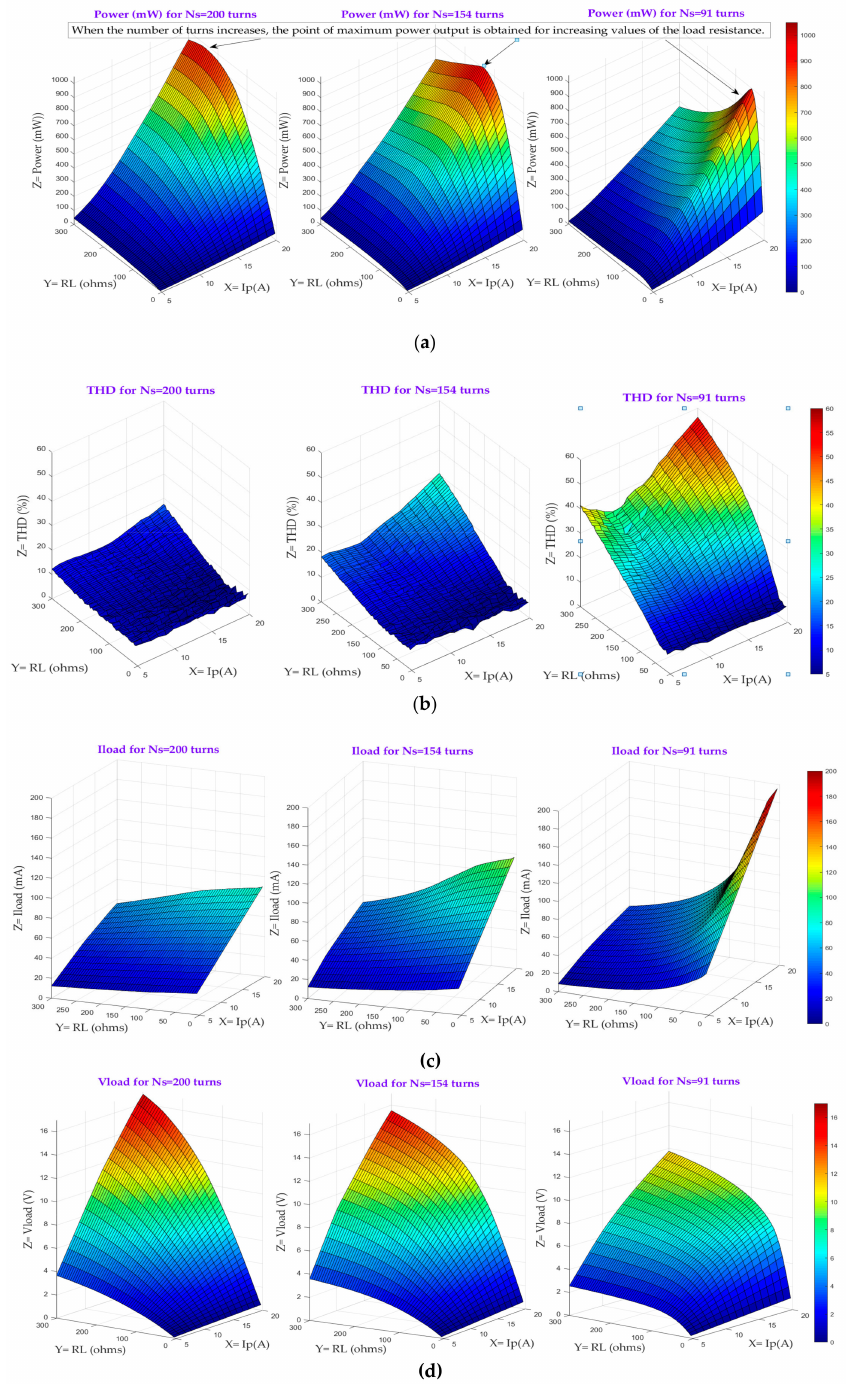
Figure 5. ( a ) Output power; ( b ) THD; ( c ) V load ; and ( d ) I load as a function of I p , R L and